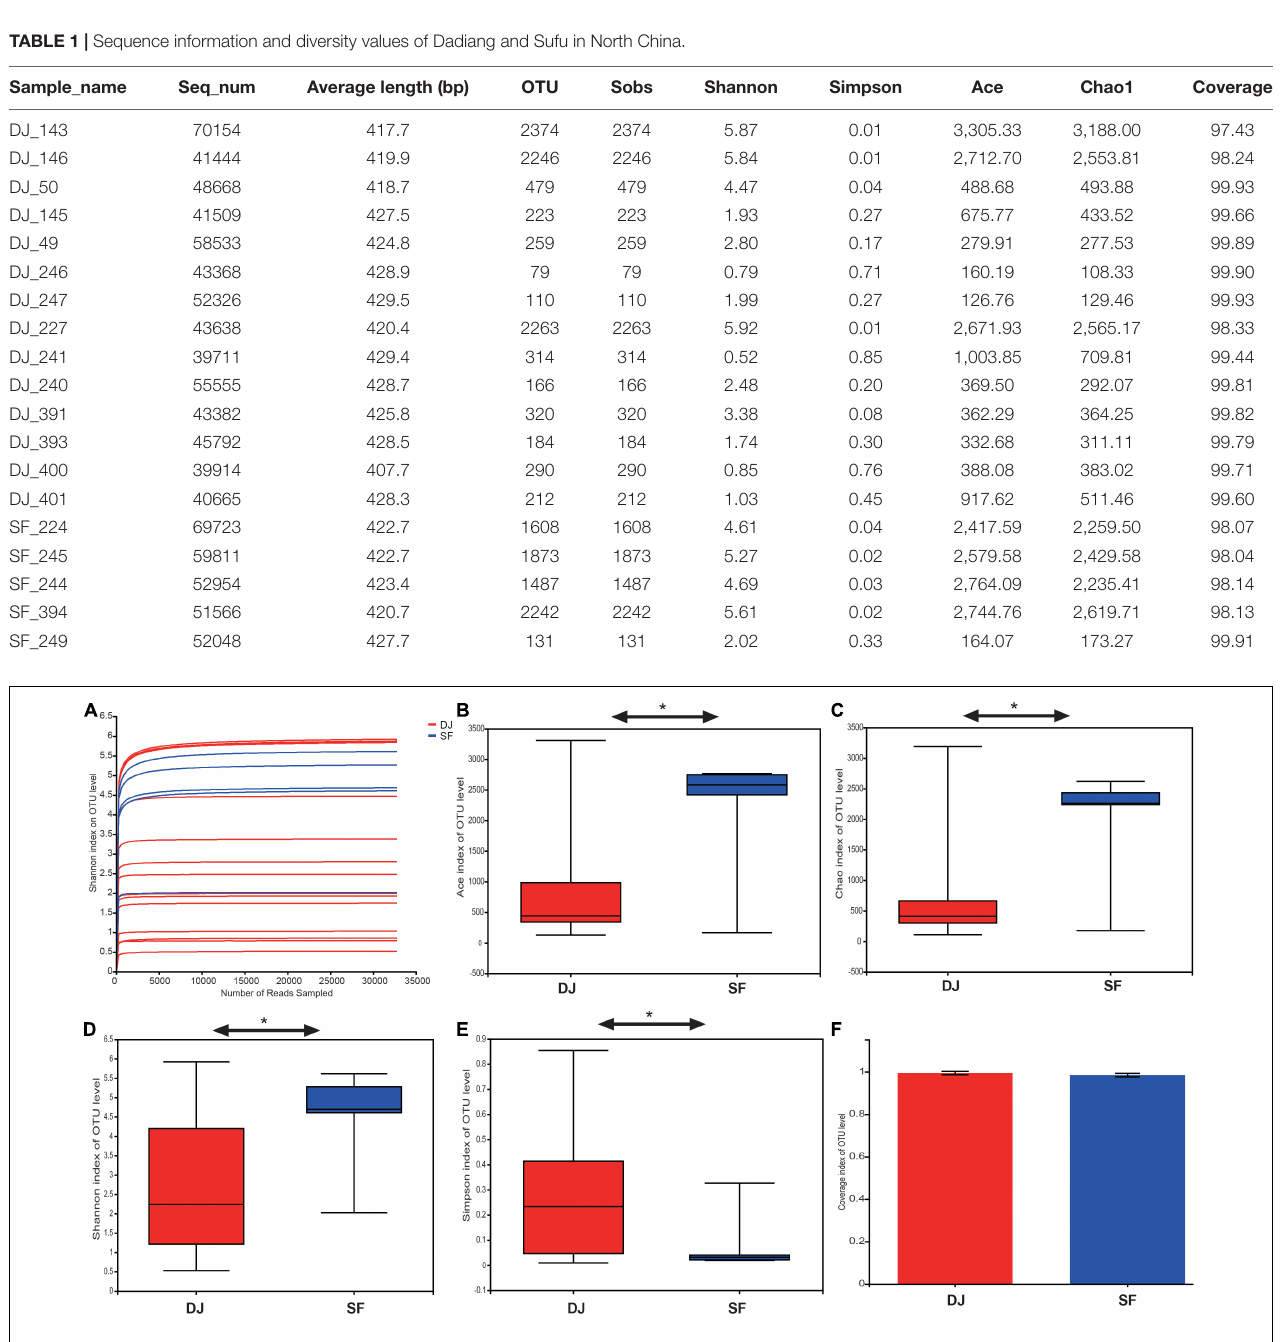
FIGURE 2 | Alpha-diversity and similarity of bacterial communities in Dajiang and Sufu. (A) Shannon curve; (B) Ace; (C) Chao1; (D) Shannon index; (E) Simpson index; (F) Coverage; Statistical significance between groups was determined using t -tests * P < 0.05.